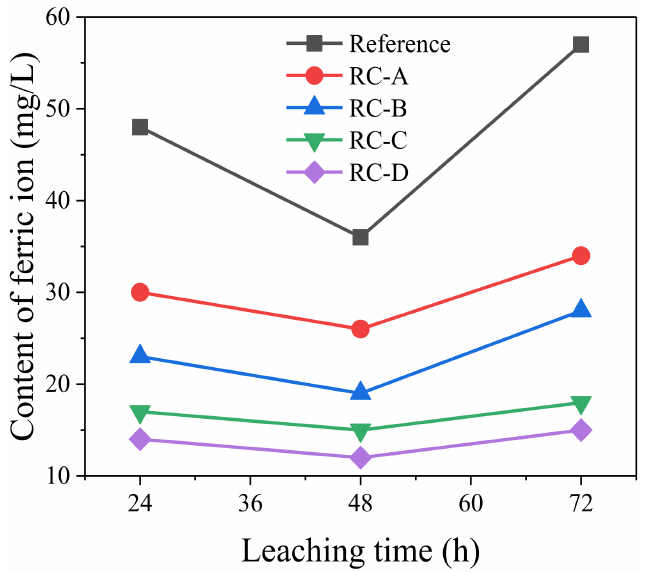
Figure 4. The Fe 3+ concentration of rusty steel sheets treated with RC-A, RC-B, RC-C, and RC-D at different immersion